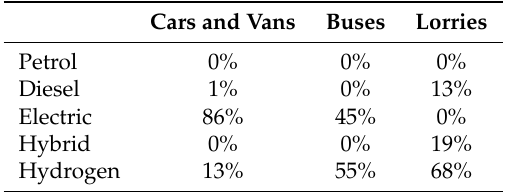
Table 5. Vehicle and fuel distribution in scenario